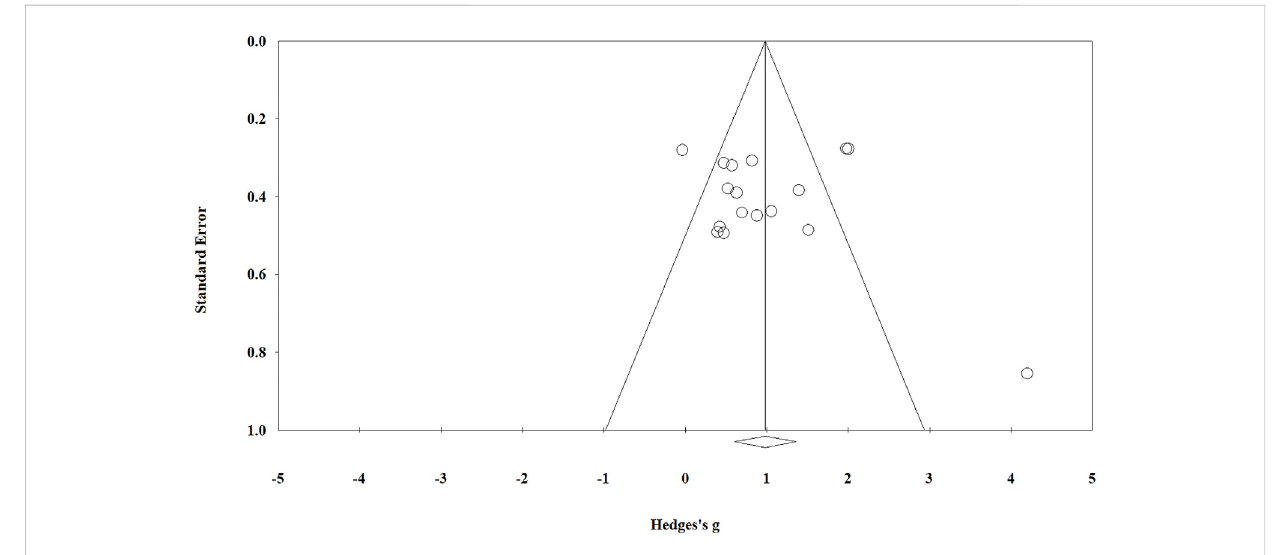
FIGURE 3 Funnel plot of publication